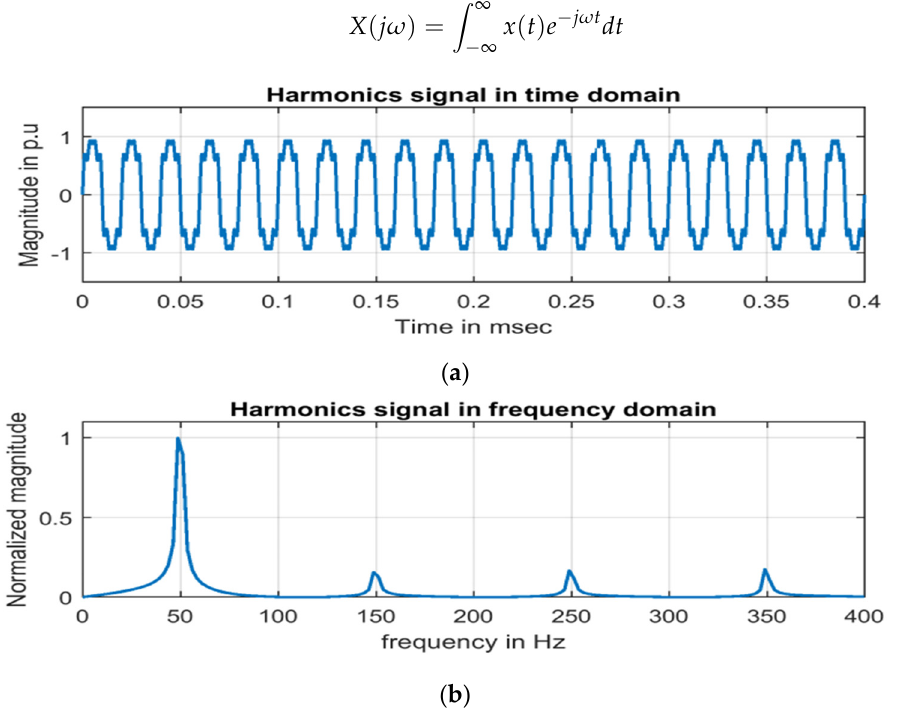
Figure 3. Harmonics signal: ( a ) time domain and ( b ) frequency domain.